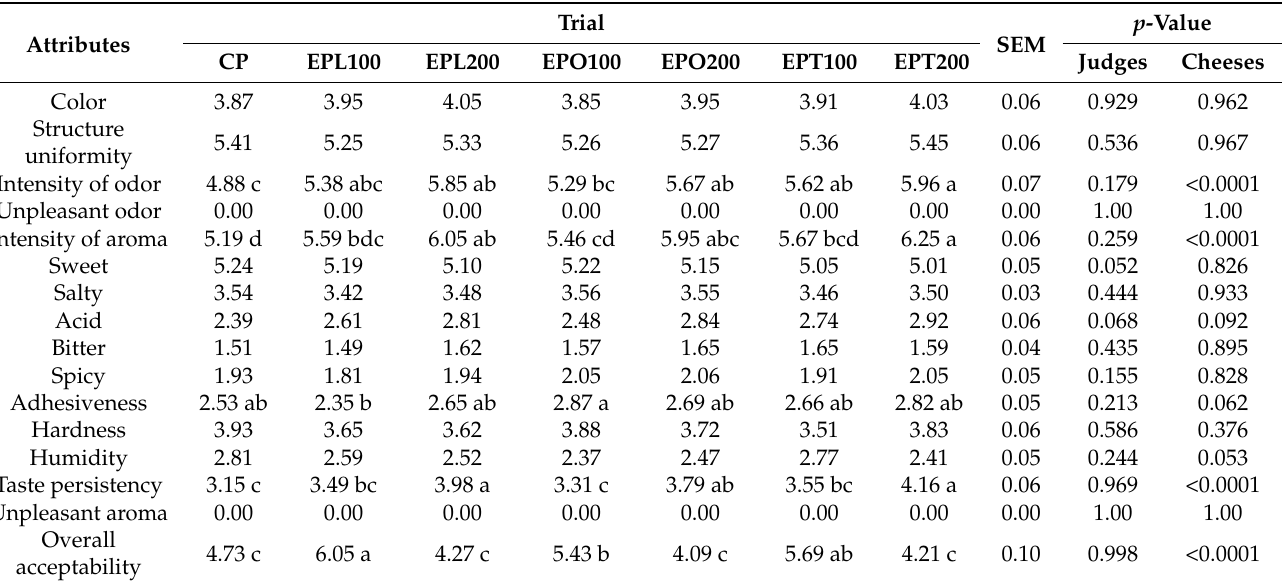
Table 6. Evaluation of the sensory attributes of Primosale